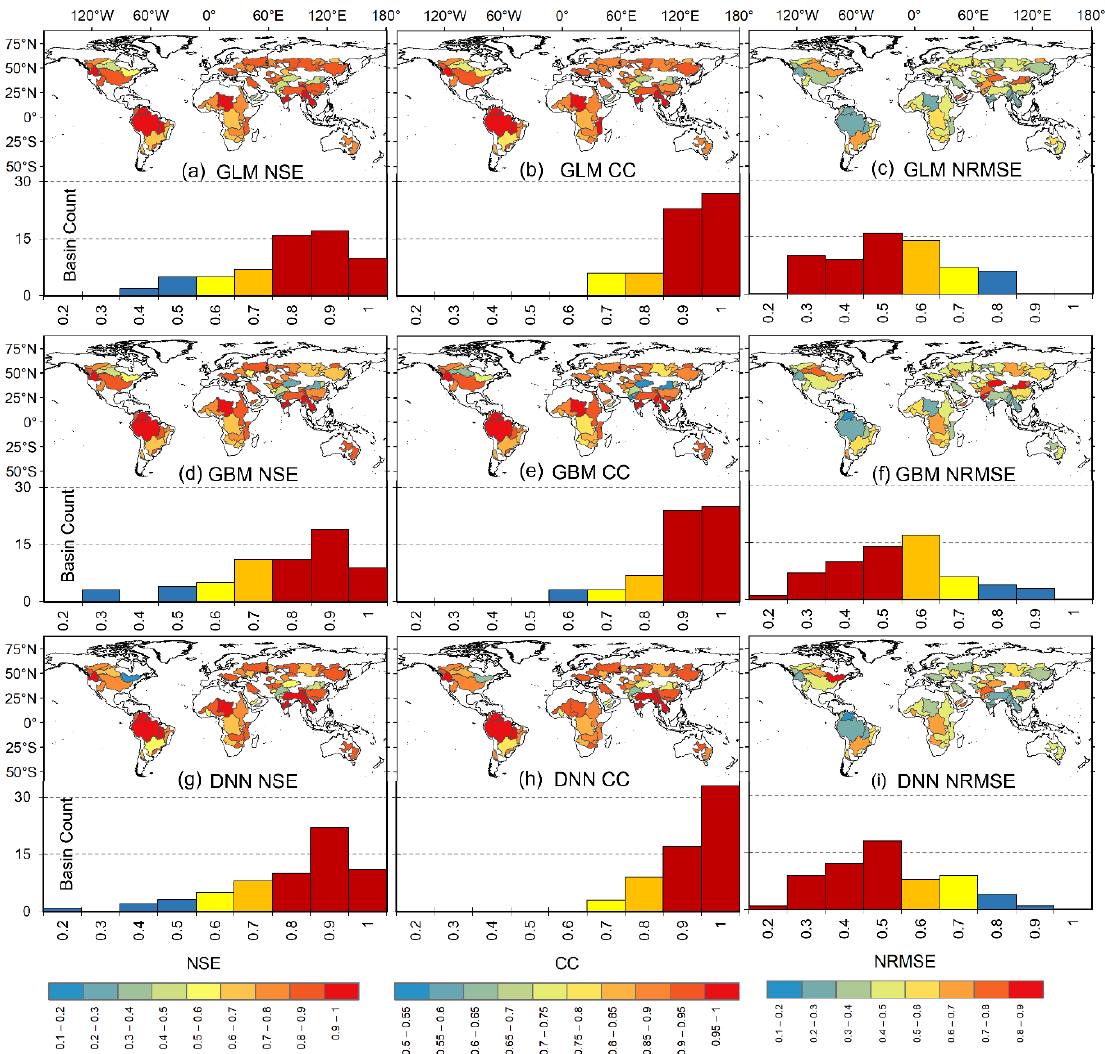
Figure 7. Spatial and frequency (bar plot) distribution of the basin-scale testing performance for the ( a – c ) GLM, ( d – f ) GBM, and ( g – i ) DNN models. The color-coded frequency distribution shows the very good (red), good (orange), satisfactory (yellow), and poor (blue) performance categories. The GBM model’s general performance is estimated to be NSE = 0.73 ± 0.17, CC = 0.85 ± 0.11, NRMSE = 0.49 ± 0.16 (Figure 7d–f, and Table 2). The performance of GBM is very good for 53% of the investigated basins (e.g., Orinoco [NSE = 0.96, CC = 0.98, NRMSE = 0.19], Lake Chad, Columbia, Amazon, Godavari, Mekong, Don, and Ural), good for 26%, and satisfactory for 10% of the investigated basins (Figure 4b). The